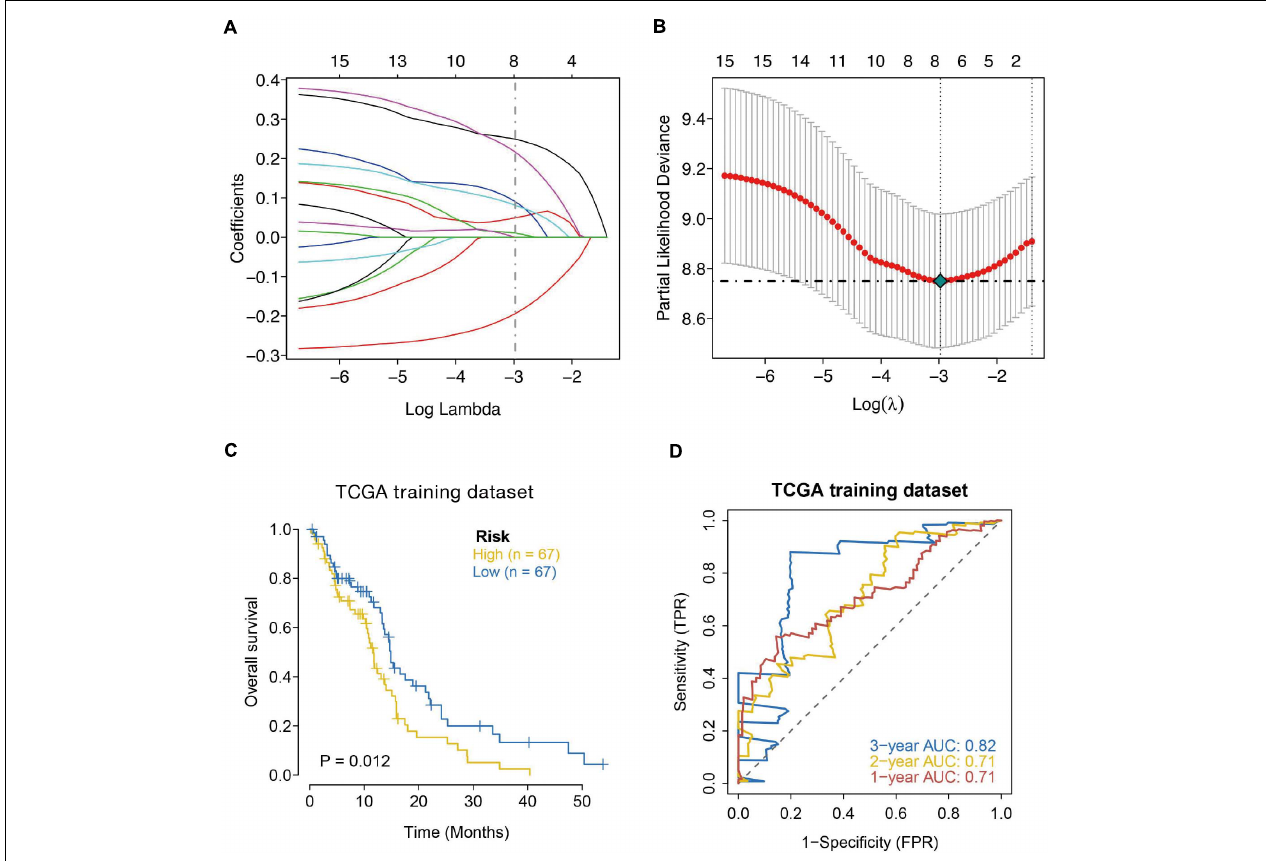
FIGURE 3 | Seven-immune-related gene signature prognostic risk model analysis of GBM patients in TCGA dataset. (A) LASSO coefficient profiles of the 15 IRGs in TCGA-GBM. (B) A coefficient profile plot was generated against the log (lambda) sequence. Selection of the optimal parameter (lambda) in the LASSO model for TCGA. (C) Kaplan–Meier survival curves for high-risk and low-risk groups. (D) ROC curves to examine the predictive accuracy of the model for OS at 1-, 2-, and 3- years.